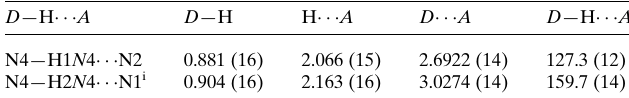
Table 1 Hydrogen-bond geometry (A˚ , (cid:4) ).